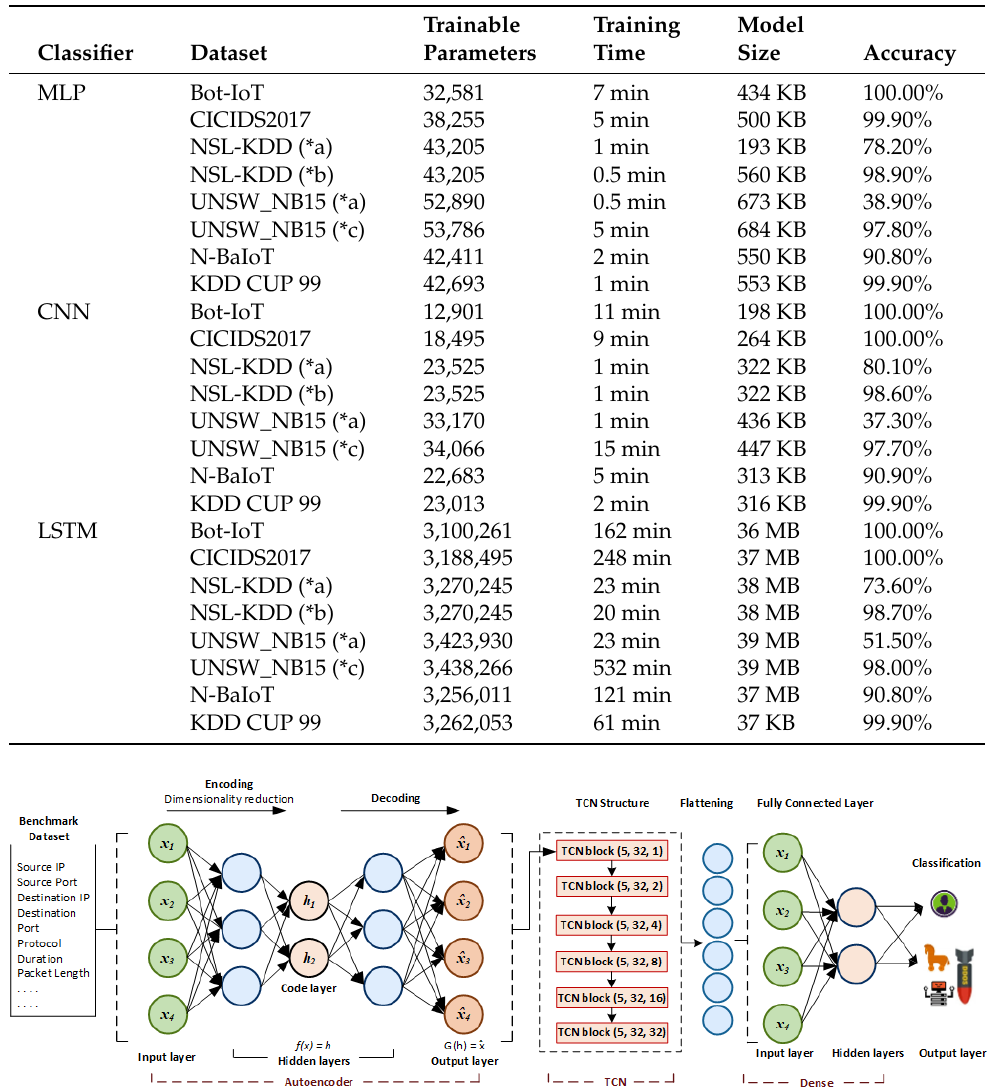
Table 2. Individual DL classifiers summary.